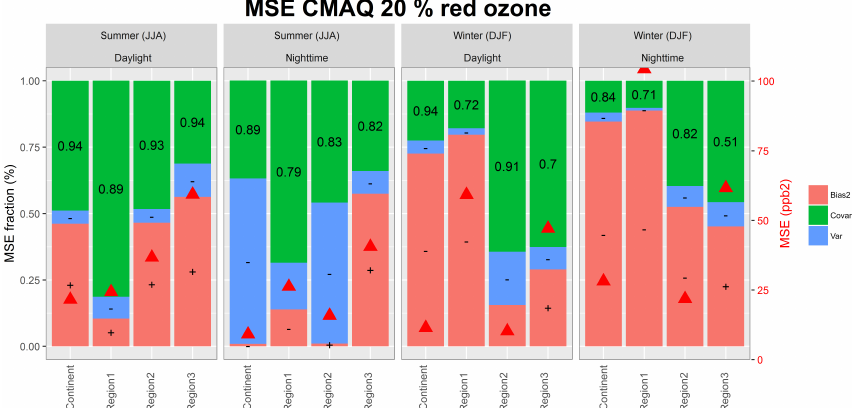
Figure 7. As in Fig. 6 for the hourly time series of “20% reduction”